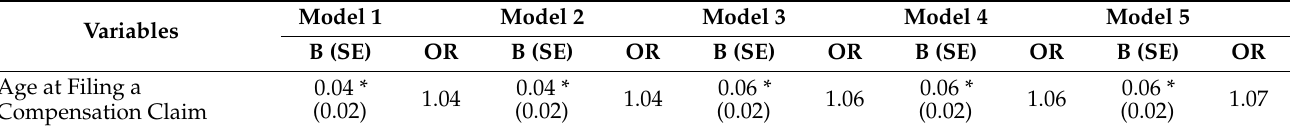
Table 3. Hierarchical logistic regression models: Prediction of depression (N =